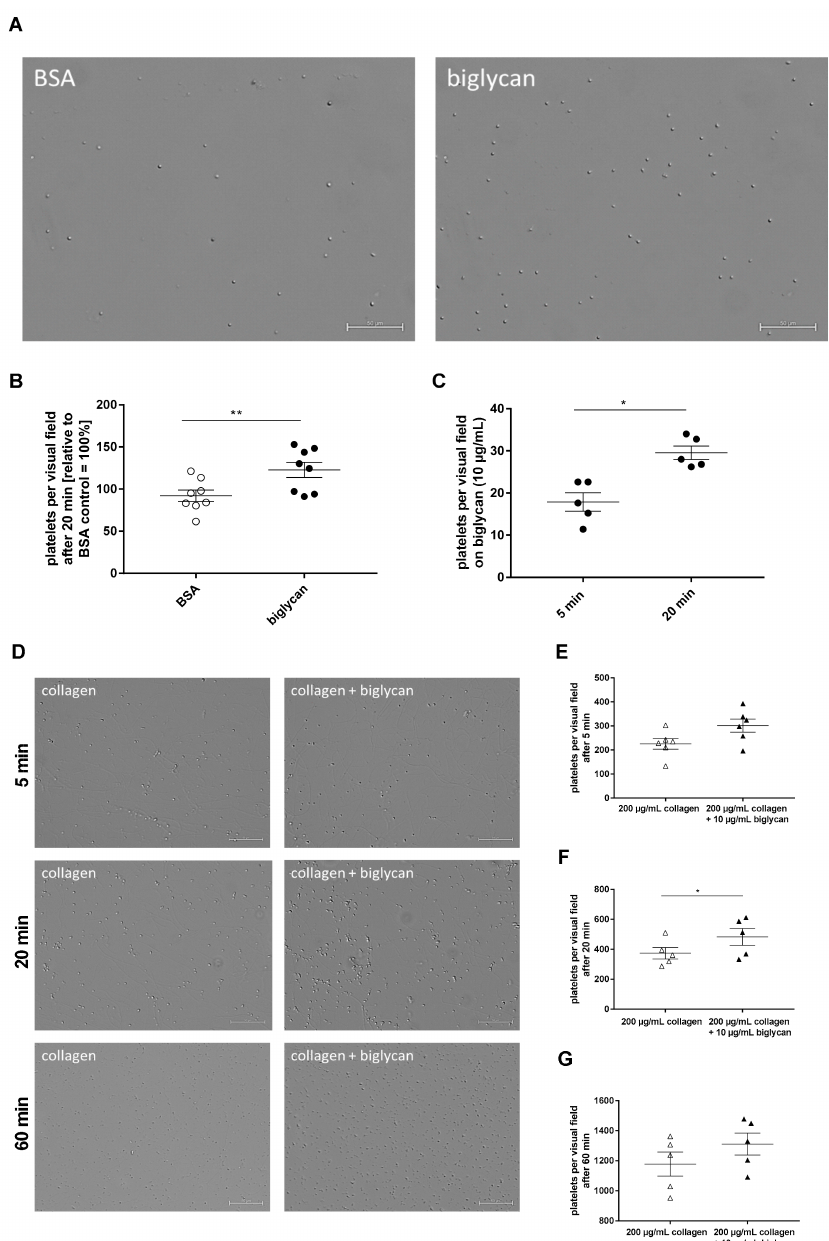
Figure 2. Murine platelets are able to adhere to immobilized biglycan and show enhanced adhesion and surface coverage on a biglycan-collagen matrix. ( A ) Representative images show adherent murine platelets to immobilized recombinant biglycan (10 µ g/mL) compared to BSA (10 mg/mL) that serves as negative control, taken 20 min after start of incubation. Scale bar = 50 µ m. ( B ) Quantitative analysis of platelet adhesion to biglycan (10 µ g/mL) after 20 min compared to adhesion on a BSA matrix (10 µ g/mL) = 100%, n = 8. ( C ) Platelet adhesion to immobilized biglycan (10 µ g/mL) after 5 and 20 min revealed an elevated number of adherent platelets on biglycan with increased time of incubation, N = 5. ( D ) Representative images show adherent platelets on a collagen matrix (200 µ g/mL) compared to a biglycan-collagen (10/200 µ g/mL) matrix at different time points. Scale bar = 50 µ m. ( E – G ) Quantification of adherent platelets after 5 ( E ), 20 ( F ), and 60 min ( G ) of incubation on collagen (200 µ g/mL) and biglycan (10 µ g/mL)-collagen (200 µ g/mL) matrices. Mean values ± SEM. Statistical analysis was performed with two-tailed paired Student’s t -test, * p ≤ 0.05, ** p <